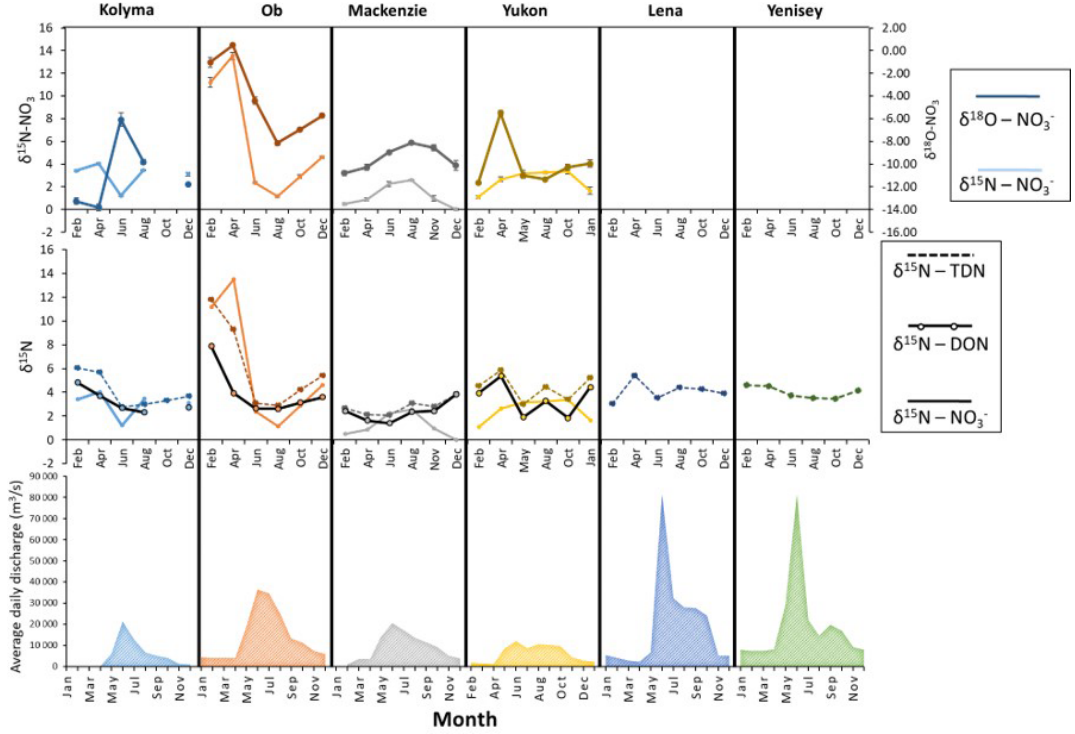
Figure 7. Seasonal nitrogen (and oxygen) isotopic trends for all six Arctic GRO rivers. Nitrate isotopes as part of the dual isotope technique ( δ 15 N and δ 18 O) are shown on (a) . Nitrogen isotopes of TDN, nitrate, and DON, note the one scale for all three, are shown in (b) . Seasonal discharges are also shown in (c) . Only δ 15 N values of TDN were plotted for the Lena and Yenisey, since nitrate concentrations were very low for dual isotopic analysis of nitrate, hence δ 15 N-NO − and δ 18 O-NO − values were not obtained. However, since nitrate concentrations were 3 3 very small in comparison to DON (see Fig. 6), then it can be assumed that the nitrogen isotopic signature of DON is approximately equal to the signature of TDN ( δ 15 N-DON ≈ δ 15